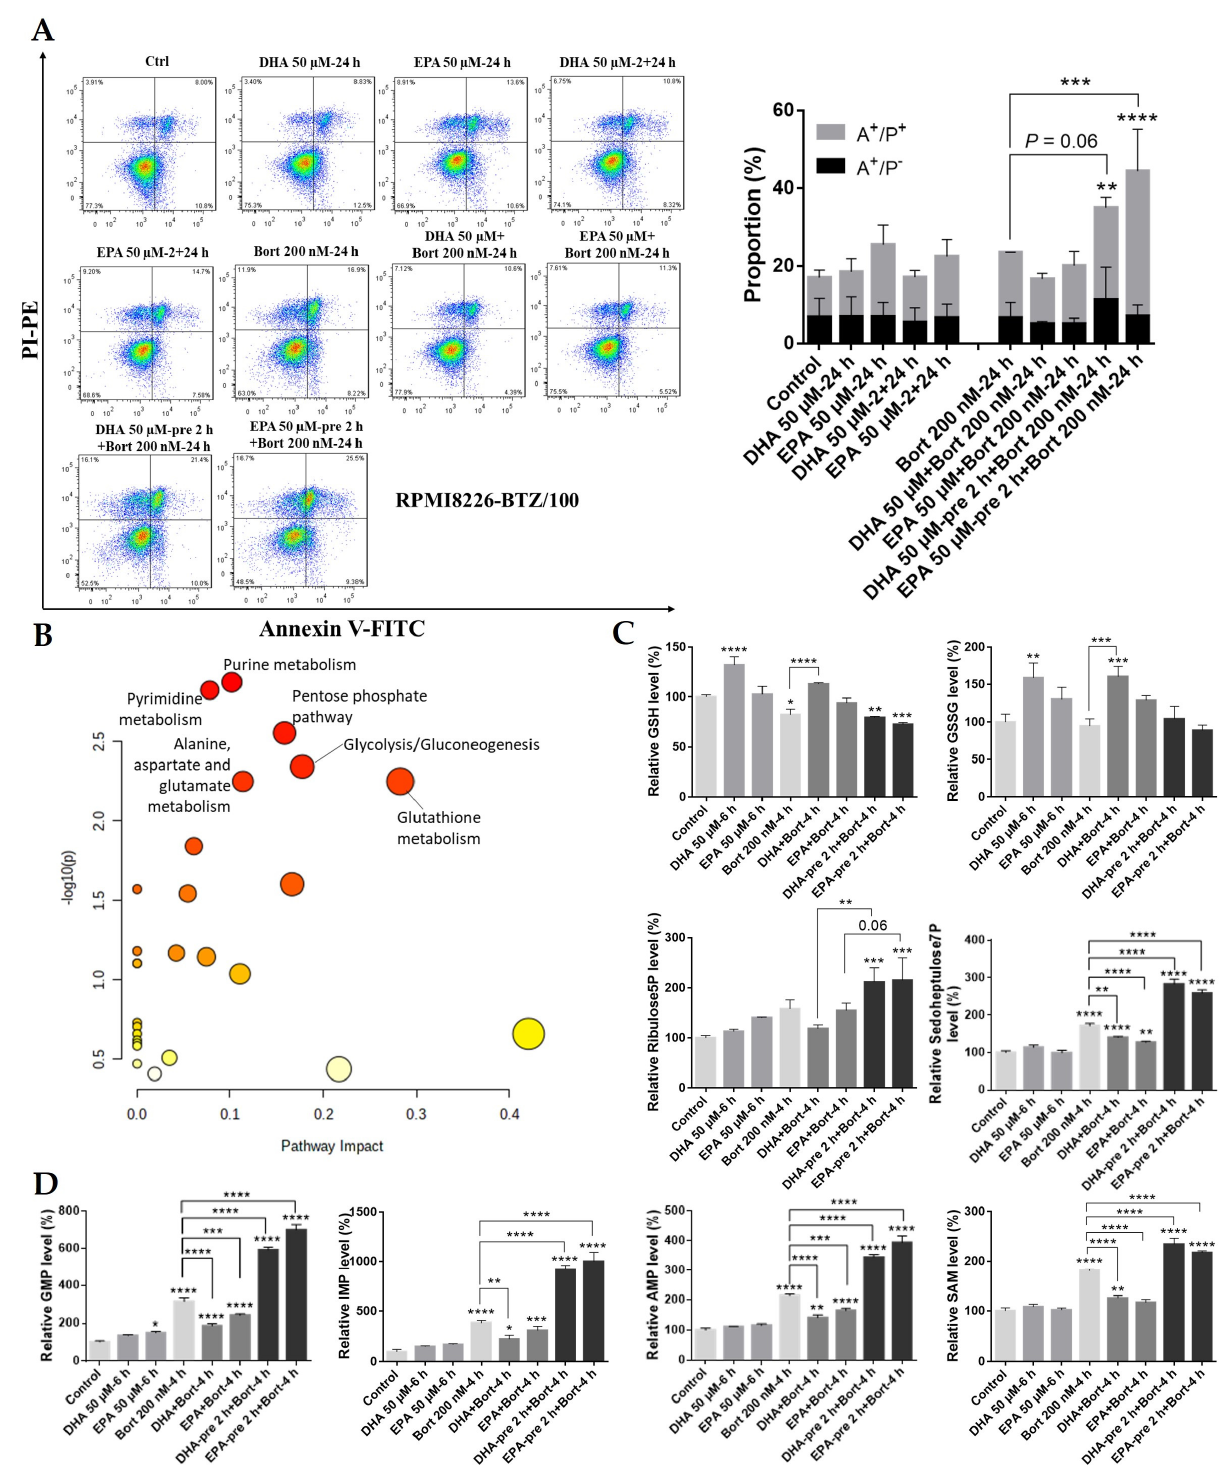
Figure 5. GSH metabolism plays a critical role in increasing bortezomib chemosensitivity in the bortezomib-resistant MM cell line. ( A ) RPMI8226-BTZ/100 was pretreated with 50 µ M of DHA or EPA for 0 or 2 h and then incubated with bortezomib (200 nM) for 24 h. Apoptotic cells were determined by Annexin-V and PI staining. ( B ) Metabolome pathway enrichment of 24 differentially regulated metabolites using MetaboAnalyst 5.0. The node color represents the p values, and the node size represents the pathway impact values. ( C ) and ( D ) The levels of the indicated metabolites upon different treatment. Data are presented as mean ± SD of three independent treatment. * p < 0.05, ** p < 0.01, *** p < 0.001, **** p < 0.0001 when compared with the